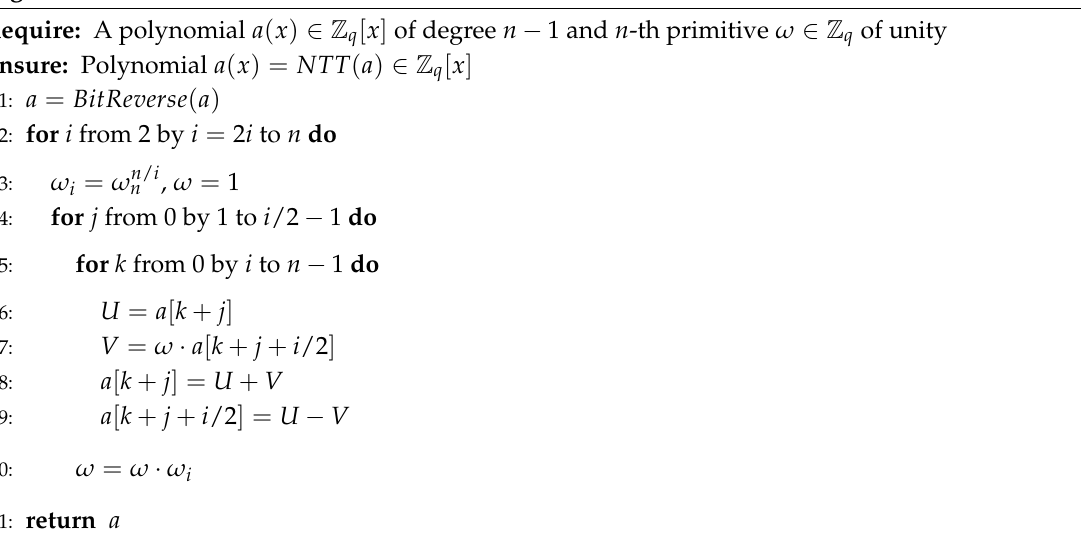
Algorithm 1 Iterative Number Theoretic